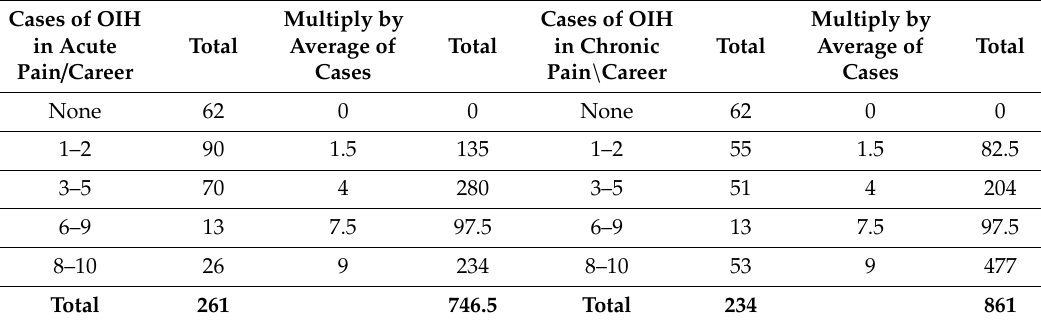
Table 4. Number of suspected cases of OIH in acute and chronic